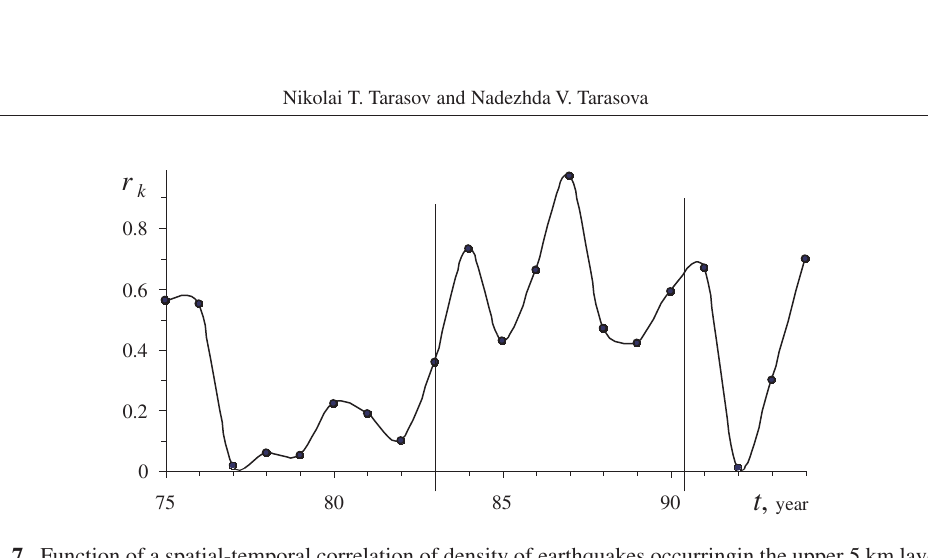
Fig. 7. Function of a spatial-temporal correlation of density of earthquakes occurringin the upper 5 km layer of crust of the North Tien Shan and adjacent areas. The vertical axis indicates the values of a correlation function r k ; the horizontal axis indicates time in years. The vertical points are the time of beginning and termination of a series of MHD-generator start-ups on the Bishkek